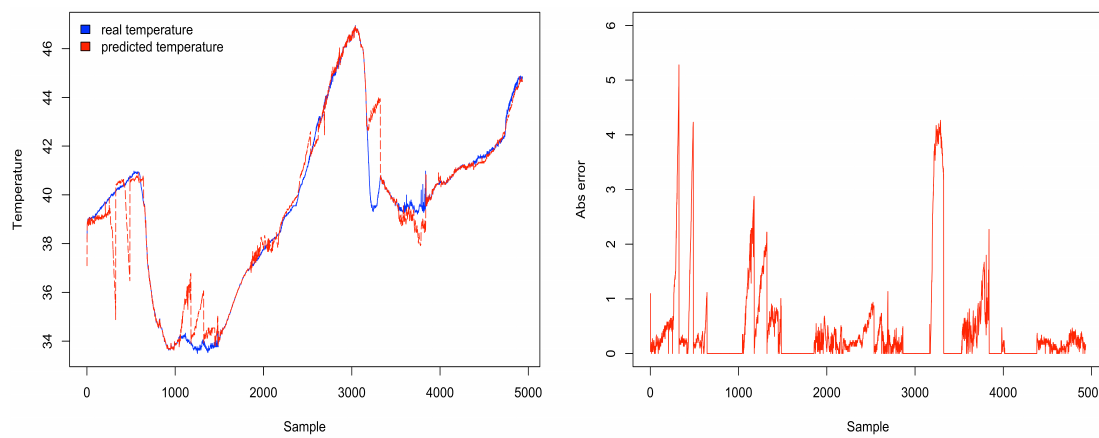
Figure 14. Real and predicted temperatures ( ◦ C) of Node 18 with THRESHOLD equal to 5.0.